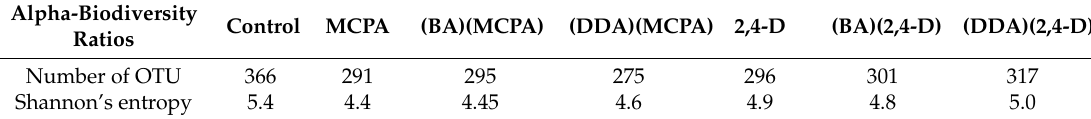
Table 4. Values of alpha-biodiversity ratios of microbial metapopulation after 30 days of